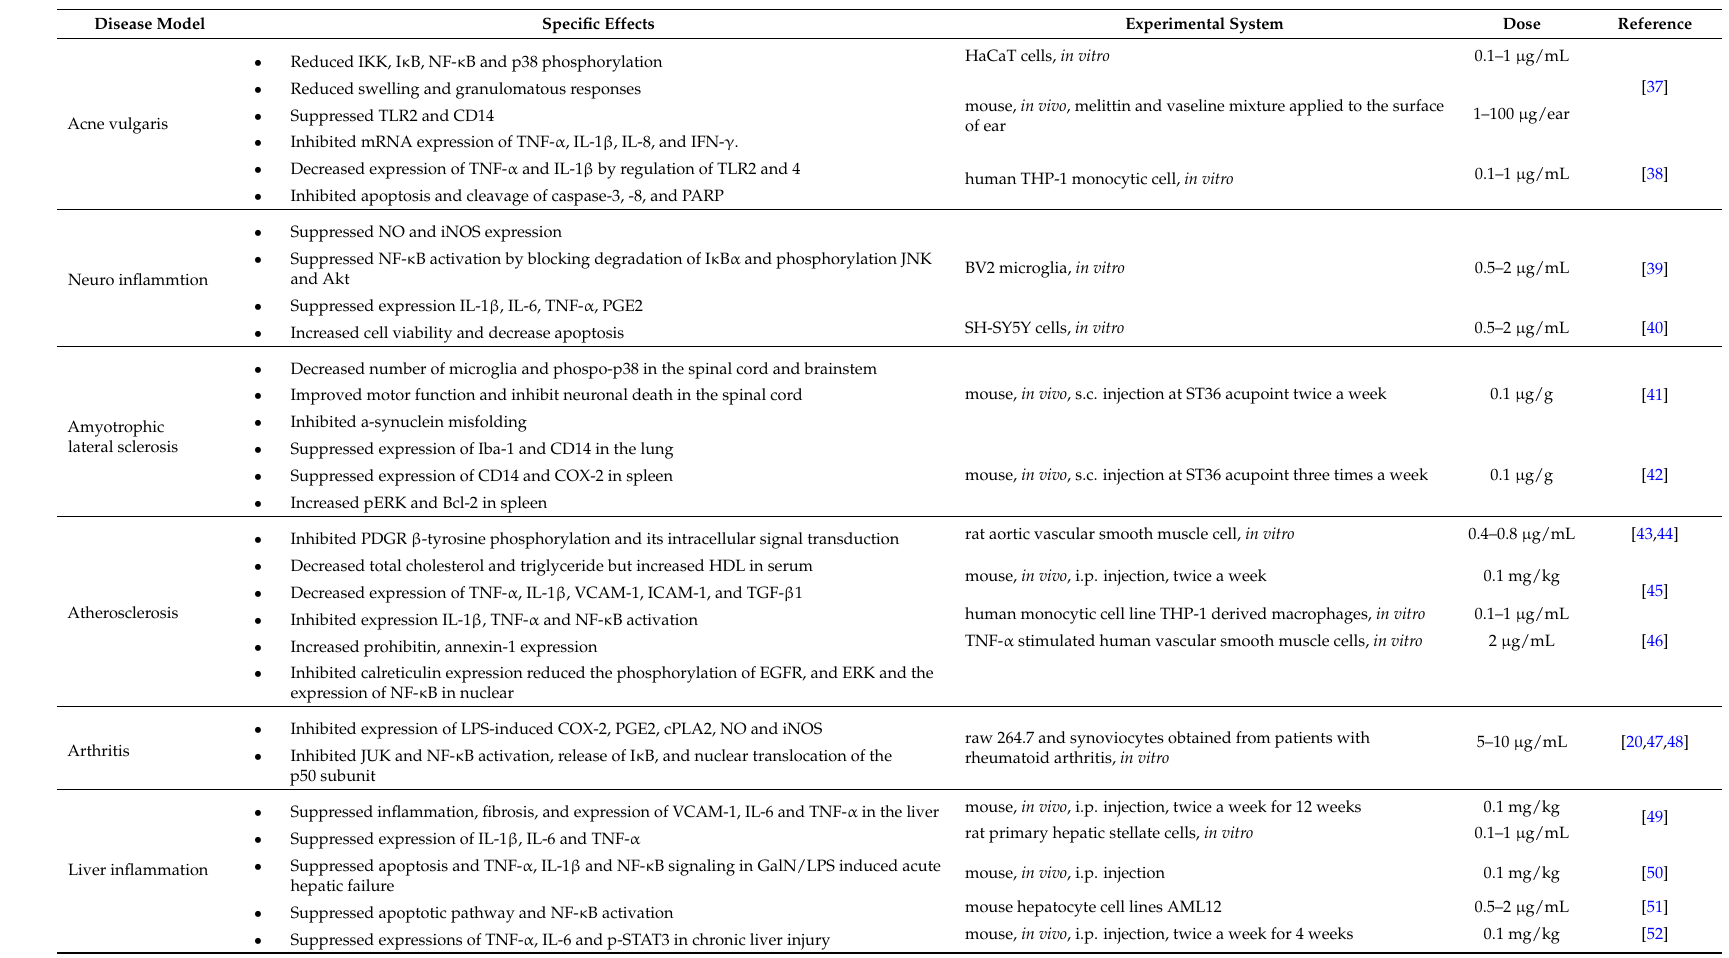
Table 1. Anti-inflammatory effects of